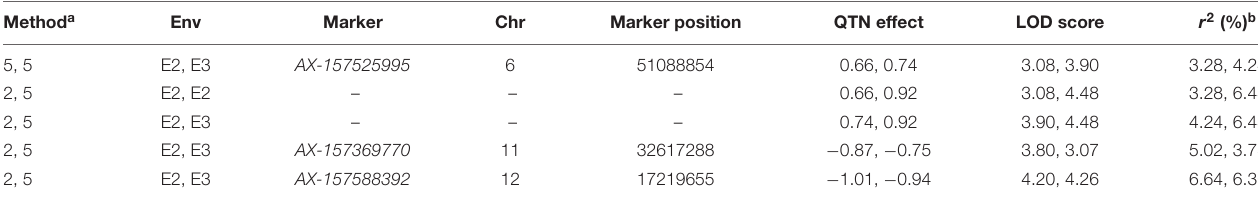
TABLE 2 | Stable expressed QTNs identified in multiple environments and by multiple